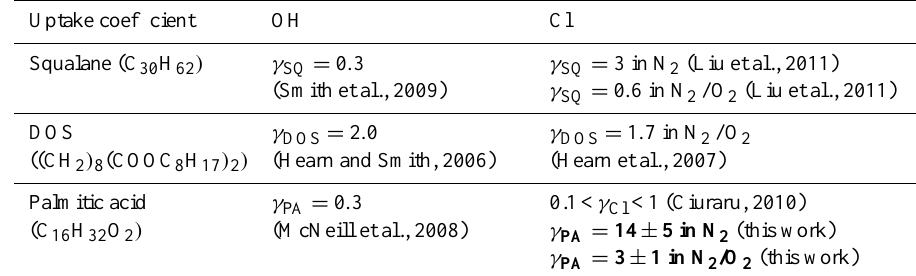
Table 1. Summary of measured uptake coefficients for heterogeneous reaction systems involving organic aerosol with the radical species q q OH and Cl .